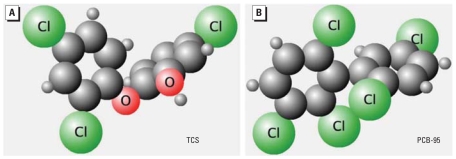
Three-dimensional projection of TCS and PCB-95 generated by ChemIDplus (National Library of Medicine 2008).